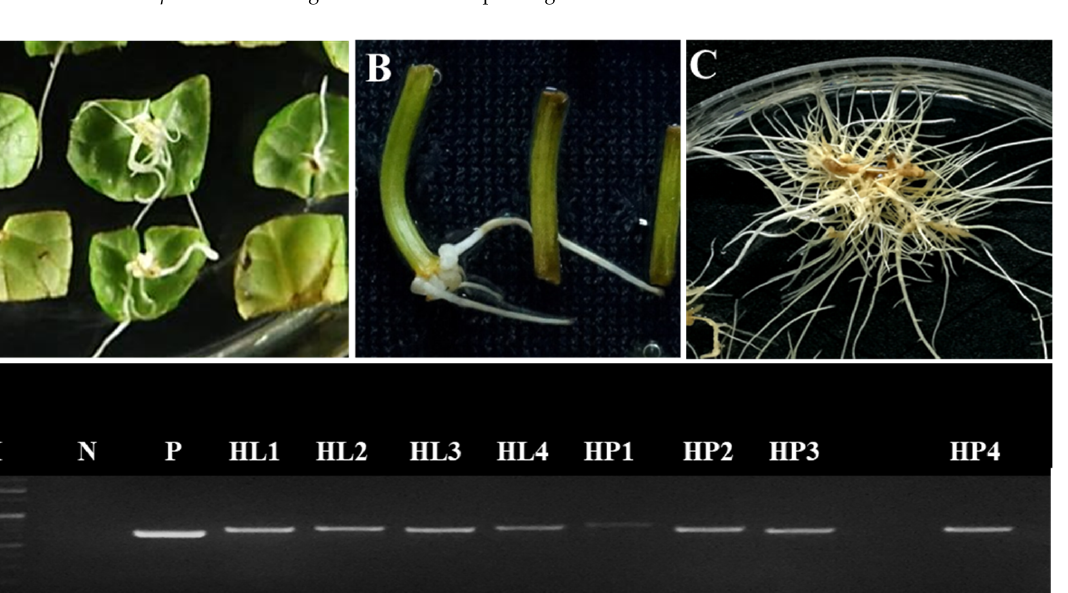
z Confirmed hairy root by rol gene detection using PCR; y Different letters indicate significant dif- ferences at p < 0.05 according to Duncan’s multiple range test.